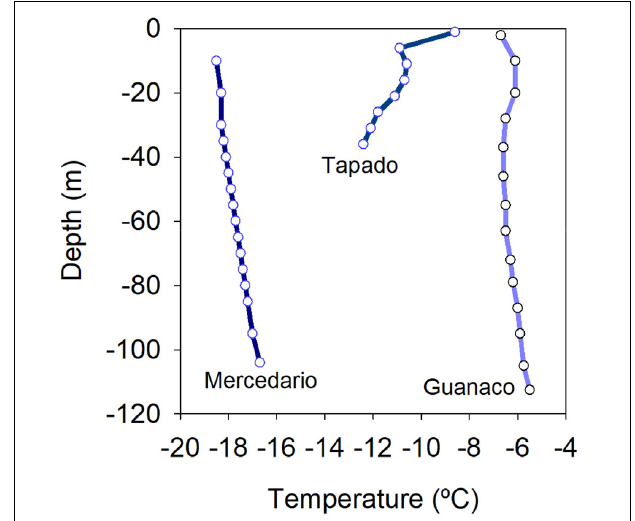
FIGURE 5 | Temperatures measured in glacier boreholes in the Desert Andes. The Mercedario glacier is located at ca. 32 ◦ S, Tapado at ca. 30 ◦ S, and Guanaco at 29.3 ◦ S (adapted from Pitte,